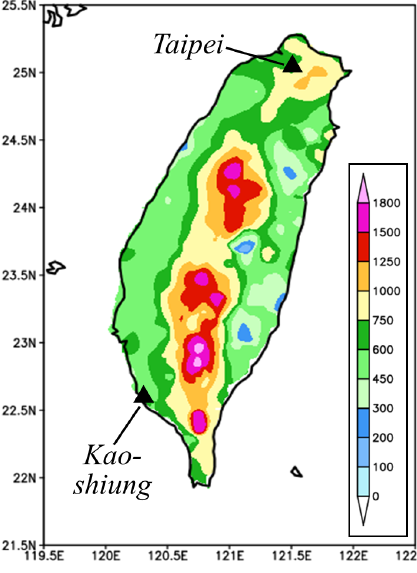
Figure 3. Spatial distribution of mean total rainfall (mm) per Mei- yu season (1 May through 30 June) in 2012–2014. The cities of Taipei and Kaohsiung are